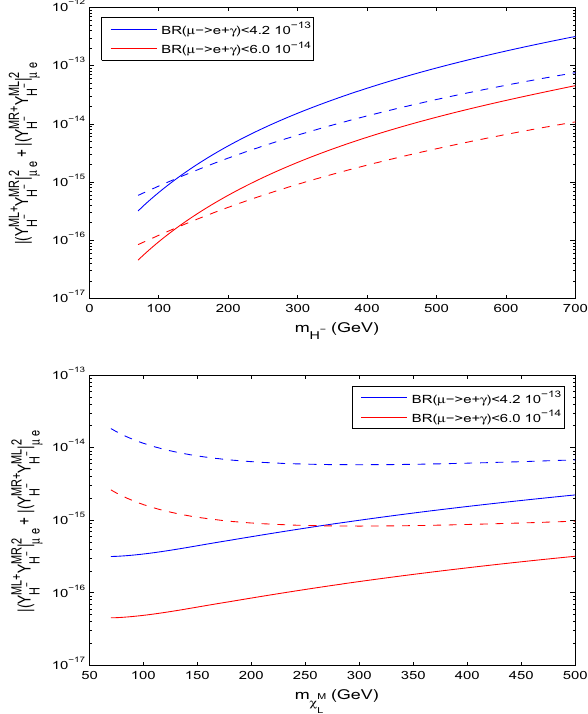
Fig. 3 Upper bounds on Yukawa couplings by μ → e γ decay as functions of (i) singly charged Higgs mass (upper panel) for m χ M 80 ( 200 ) GeV, solid (dashed) lines; (ii) heavy neutrino masses (lower panel) for m H − = 70 ( 300 ) GeV, solid (dashed) lines